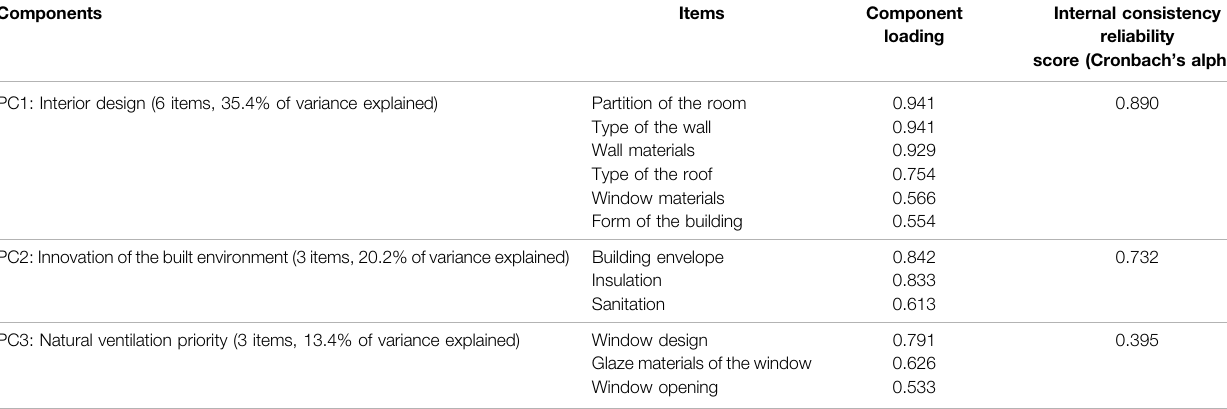
TABLE 4 | Principal component loading and reliability scores of the clustered bioclimatic parameters.